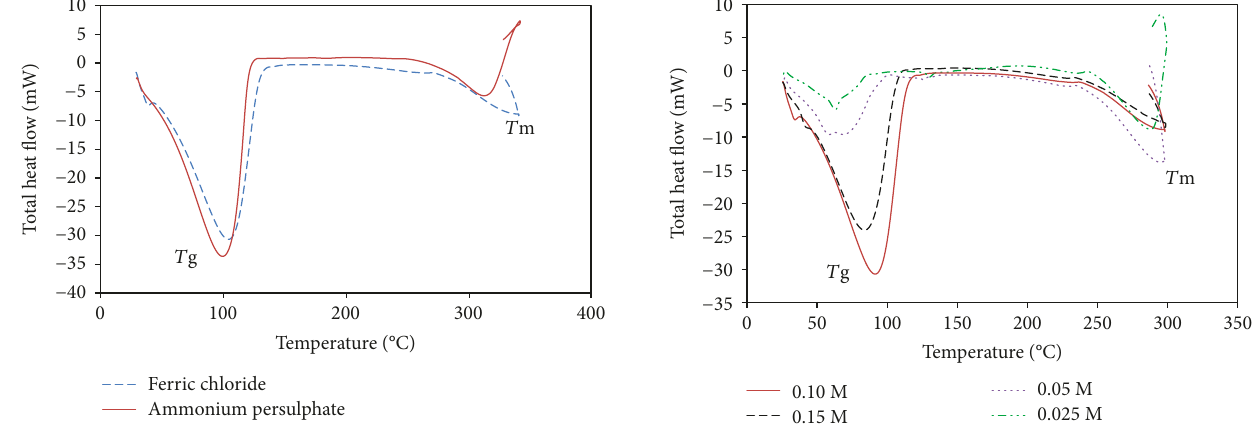
Figure 7: DSC results of PPy samples with di ff erent oxidants. Pyrrole 0.05 M and 0.1 M oxidants at 25 ° C, duration 4 hrs, and surfactant 0.025M.